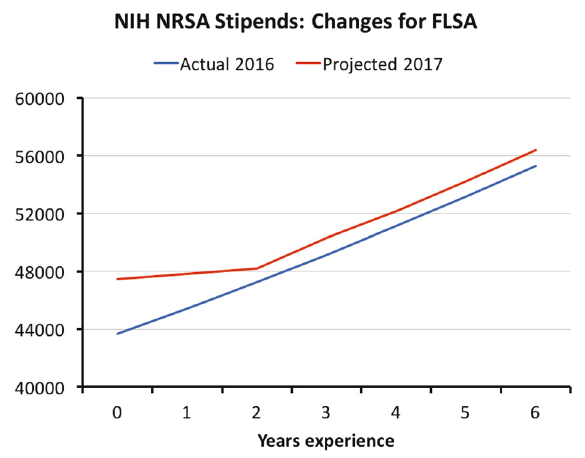
Figure 1. NRSA stipend level changes with FLSA as of December 1st 2016. The 2016 salary for postdocs on NRSA grants (blue) in 2016 increases from a minimum of $43,692 at a linear rate with increasing years of postdoctoral experience. The 2017 levels (red) will raise the minimum salary in 2017 to $47,484, which will remain relatively constant until 2 years experience and increase linearly thereafter (data source: NIH NOT-OD-16-134, (National Institutes of Health,